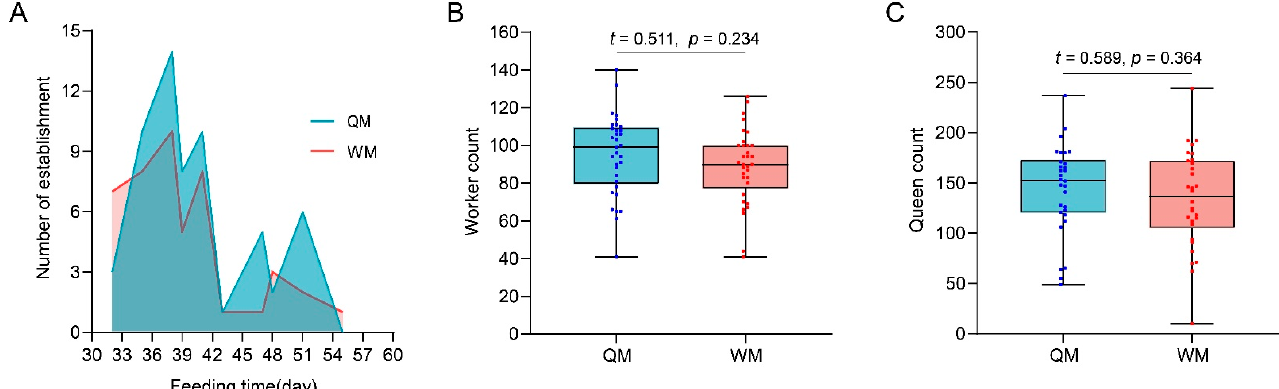
Figure 4. The survival rates and egg-laying rates of the QM- and the WM-mated queens. ( A ) The number of dead and alive QM- and WM-mated queens after diapause; ( B ) the number of laid and unlaid QM- and WM-mated queens after 20 days’ rearing. The Pearson chi-square test was used to analyze the differences in survival results of QM- and WM-mated queens after diapause and egg- laying results after 20 days’ rearing.